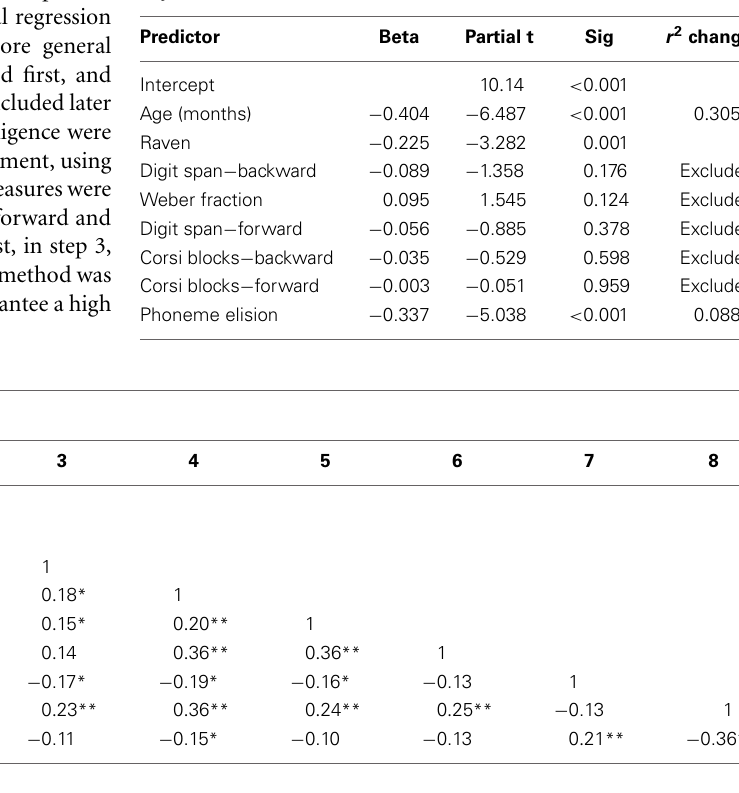
Table 2 | Regression analysis for number transcoding (errors arcsine, adjusted r 2 = 0 . 41).